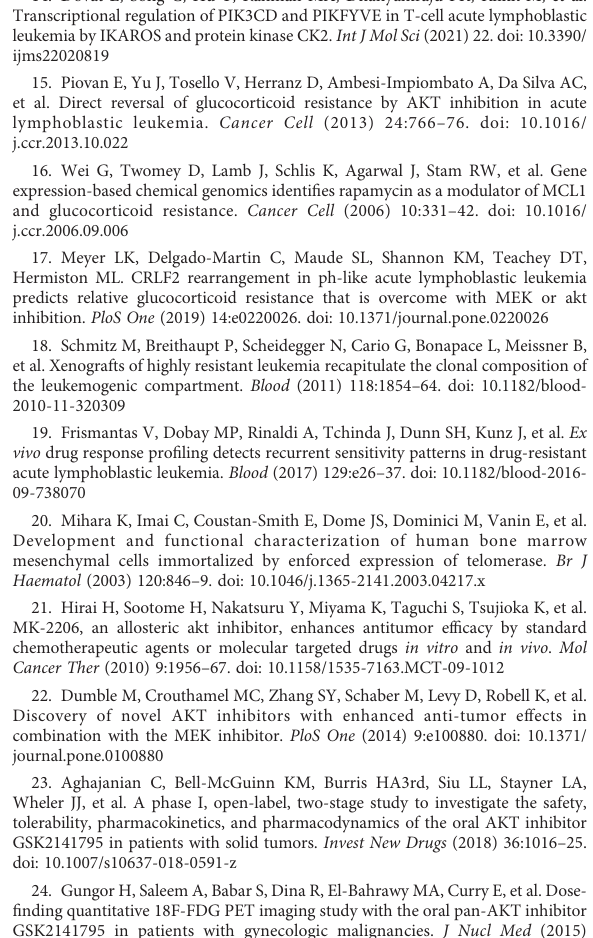
SUPPLEMENTARY FIGURE 4 Quanti fi cation of phospho-ERK, normalized for total ERK protein expression in SEM cells wildtype or de fi cient for IKZF1. The western blot results for 3 independent experiments were quanti fi ed, normalized and plotted. Differences were tested for signi fi cance using a student ’ s t-test SUPPLEMENTARY FIGURE 5 Fold change in cell viability (AUC) upon prednisolone treatment relative to iberdomide-non-treated cells. t(1;19) rearranged PDXs, wt for IKZF1, were treated with indicated concentrations iberdomide after which responses to prednisolone were determined by quanti fi cation of cells positive for amine-reactive dyes using fl ow cytometry. SUPPLEMENTARY FIGURE 6 Cell death as determined by quanti fi cation of cells positive for amine- reactive dyes using fl ow cytometry in ALL-PDXs carrying a heterozygous deletion of IKZF1 after a 3-day treatment with increasing concentrations of prednisolone in the presence or absence of 1 m M MK2206, SCH772984 or their